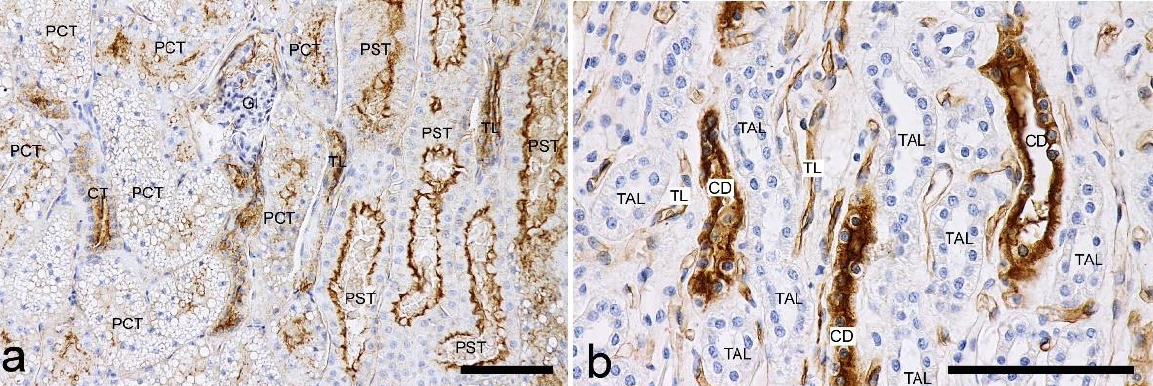
Figure 4. Histochemical staining for Ricinus communis agglutin I (RCA-I) in the feline kidney. ( a ) Low magnification view of the corticomedullary junction. A stronger staining intensity can be ob- served in the brush border of the proximal straight tubules (PSTs) than those of the proximal con- voluted tubules (PCTs). ( b ) High magnification view of the inner medulla. Positive labelings are seen in the CDs and thin limbs (TLs). Scale bars: 100 μm.